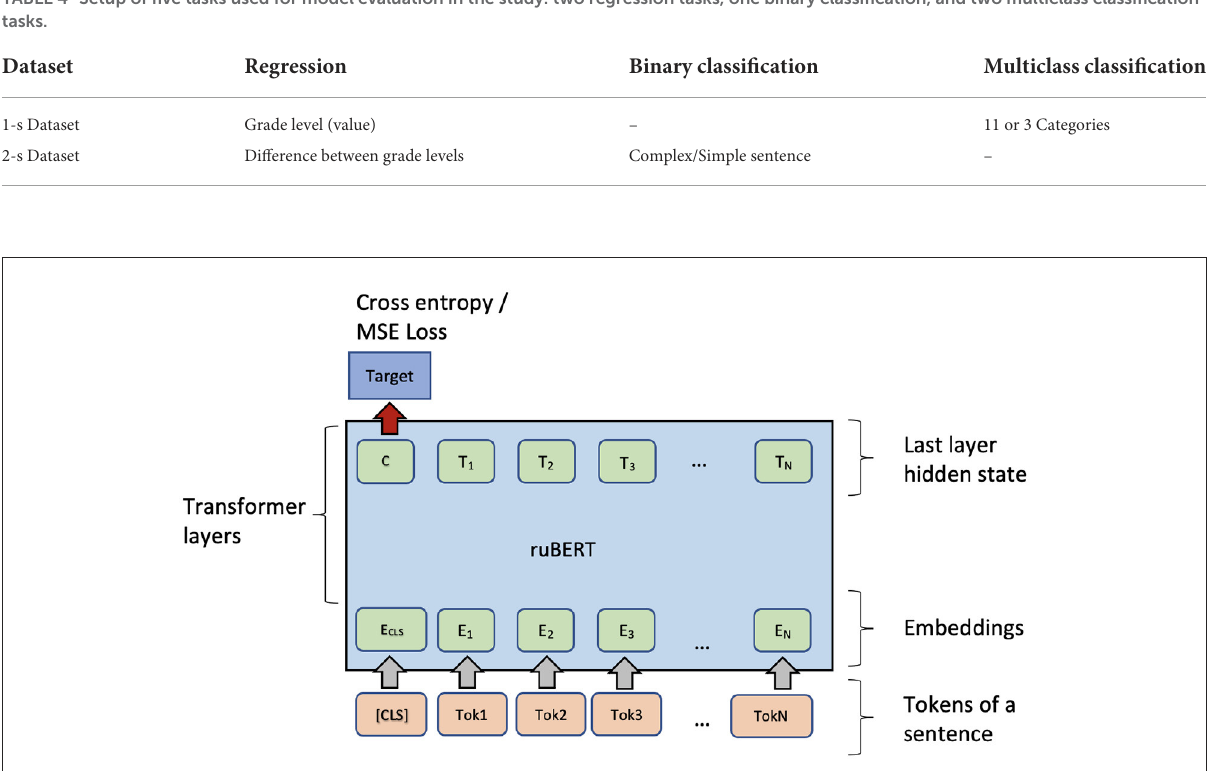
FIGURE3 Fine-tuning of RuBERT for single sentence complexity prediction.